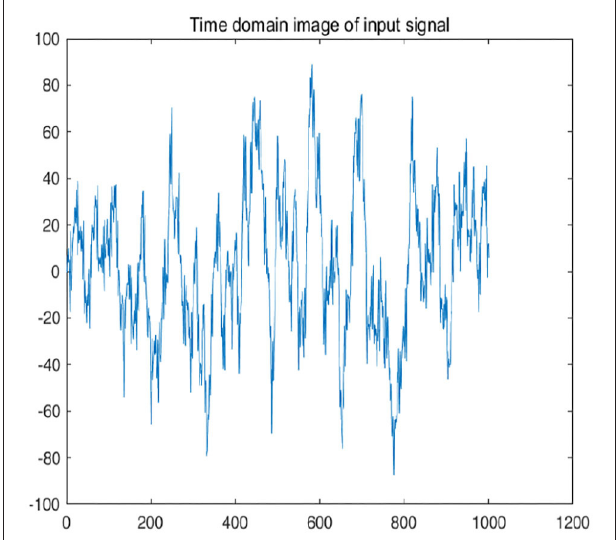
FIGURE 7 | Time-domain image of signal in pre-ictal is shown in figure.